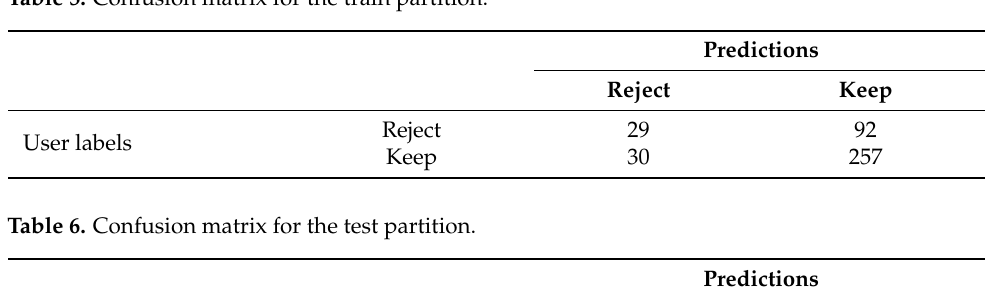
Table 5. Confusion matrix for the train partition.